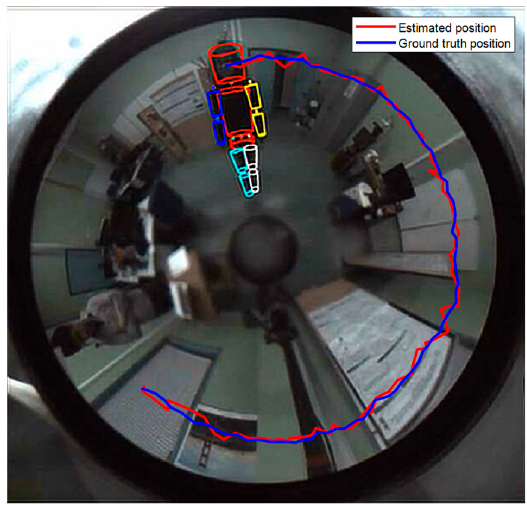
Figure 10. Head tracking results. The average location error between the estimated 3D pose of the head and the ground-truth data is about 20 mm.